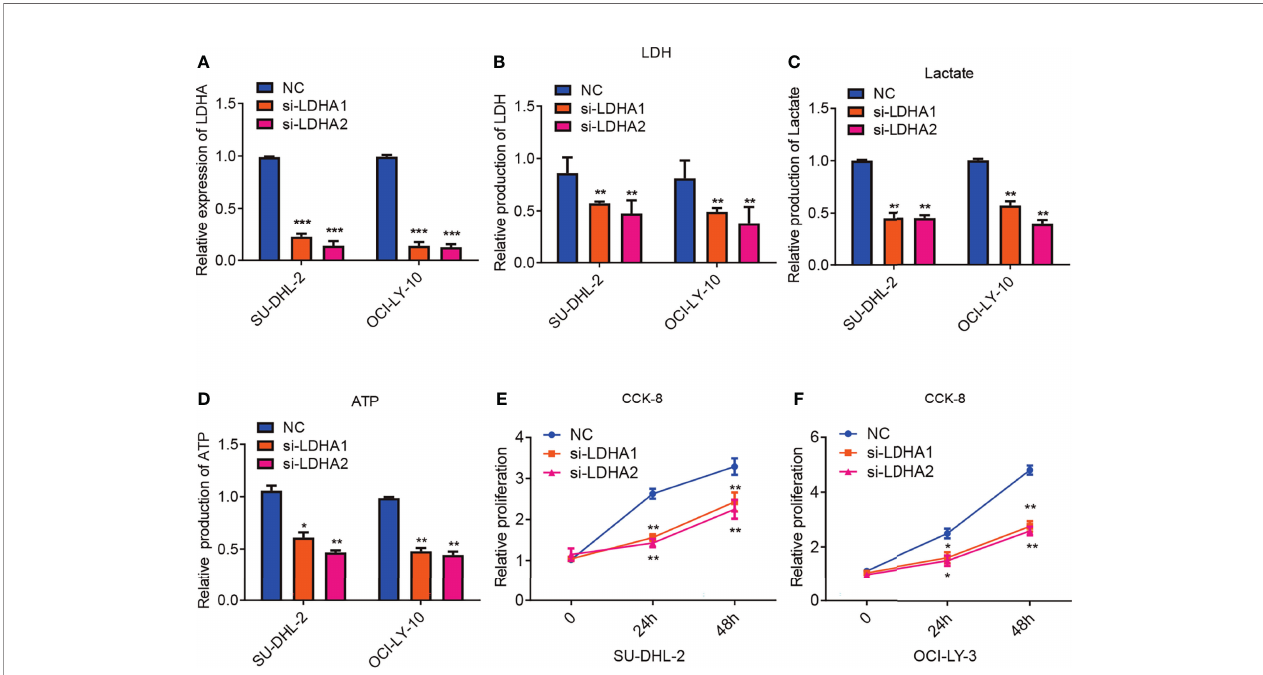
FIGURE 3 | Inhibition of LDHA attenuates glycolysis and suppresses tumor proliferation in ABC-DLBCL. (A) QRT-PCR analysis of LDHA mRNA expression in SU- DHL-2 and OCI-LY-10 cell lines. LDHA expression was detected after transfecting with siRNA of LDHA. Experiments were performed in triplicate, and data are presented as the mean ± SD. ***P < 0.001; one-way ANOVA. (B) downregulation of LDHA inhibits intracellular LDH in SU-DHL-2 and OCI-LY-10 cells. Experiments were performed in triplicate, and data are presented as the mean ± SD. **P < 0.01; and ***P < 0.001; one-way ANOVA. (C) inhibition of LDHA reduced intracellular lactate production in SU-DHL-2 and OCI-LY-10 cells. Experiments were performed in triplicate, and data are presented as the mean ± SD. **P < 0.01; one-way ANOVA. (D) inhibition of LDHA reduced ATP production in SU-DHL-2 and OCI-LY-10 cells. Experiments were performed in triplicate, and data are presented as the mean ± SD. *P < 0.05; and **P < 0.01; one-way ANOVA. (E, F) CCK8 proliferation assays were examined to determine cell proliferation of in SU-DHL-2 and OCI-LY- 10 cells after transfecting with siRNA of LDHA. A multi-way classi fi cation analysis of variance tests was performed to assess data obtained from the CCK8 assays and data are shown as mean ± SD in the bar graph for three independent experiments. *P < 0.05; **P <